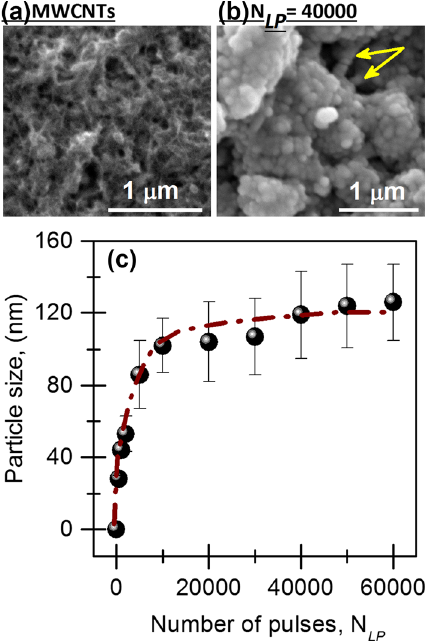
Fig. 1 Typical top-view SEM images of the a pristine MWCNTs and b MWCNTs PLD-decorated with Co–Ni NPs at N LP = 40,000; c Variation of average particle size of the Co–Ni NPs PLD-deposited onto the MWCNTs as a function of N